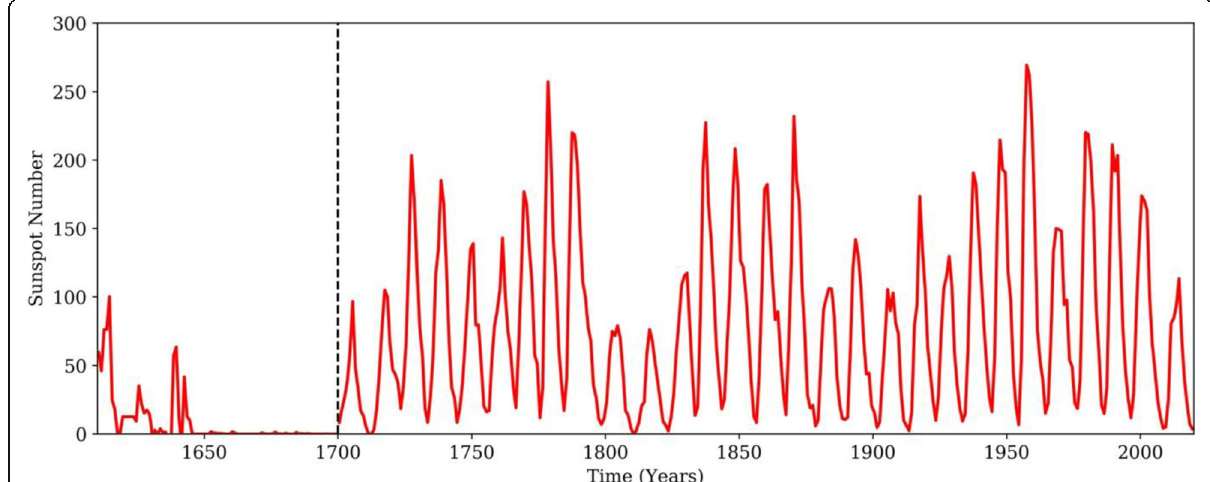
Fig. 2 The yearly mean total sunspot number time series. Observations spanning four centuries show that the number of sunspots observed on the solar surface increases and decreases in a quasi-periodic fashion with a mean period of 11 years. The plot shows the yearly mean ISN (v 2.0) from 1700 until 2019.5. The plot 1700 (the vertical dashed line) show Group Number series (v 1.0). This is scaled by a multiplicative factor of 10 to amplify the plot until the dashed line. The amplitude of sunspot cycles varies from one cycle to another and displays secular trends that are not well-understood. A phase of very low solar activity with very few sunspot observations — known as the Maunder minimum occurred between 1645 and 1715. Solar activity reconstructions over thousands of years indicate the presence of many more extremely low or strong activity phases in the solar cycle (Usoskin 2017). Credit: SILSO, Royal Observatory of Belgium, Brussels